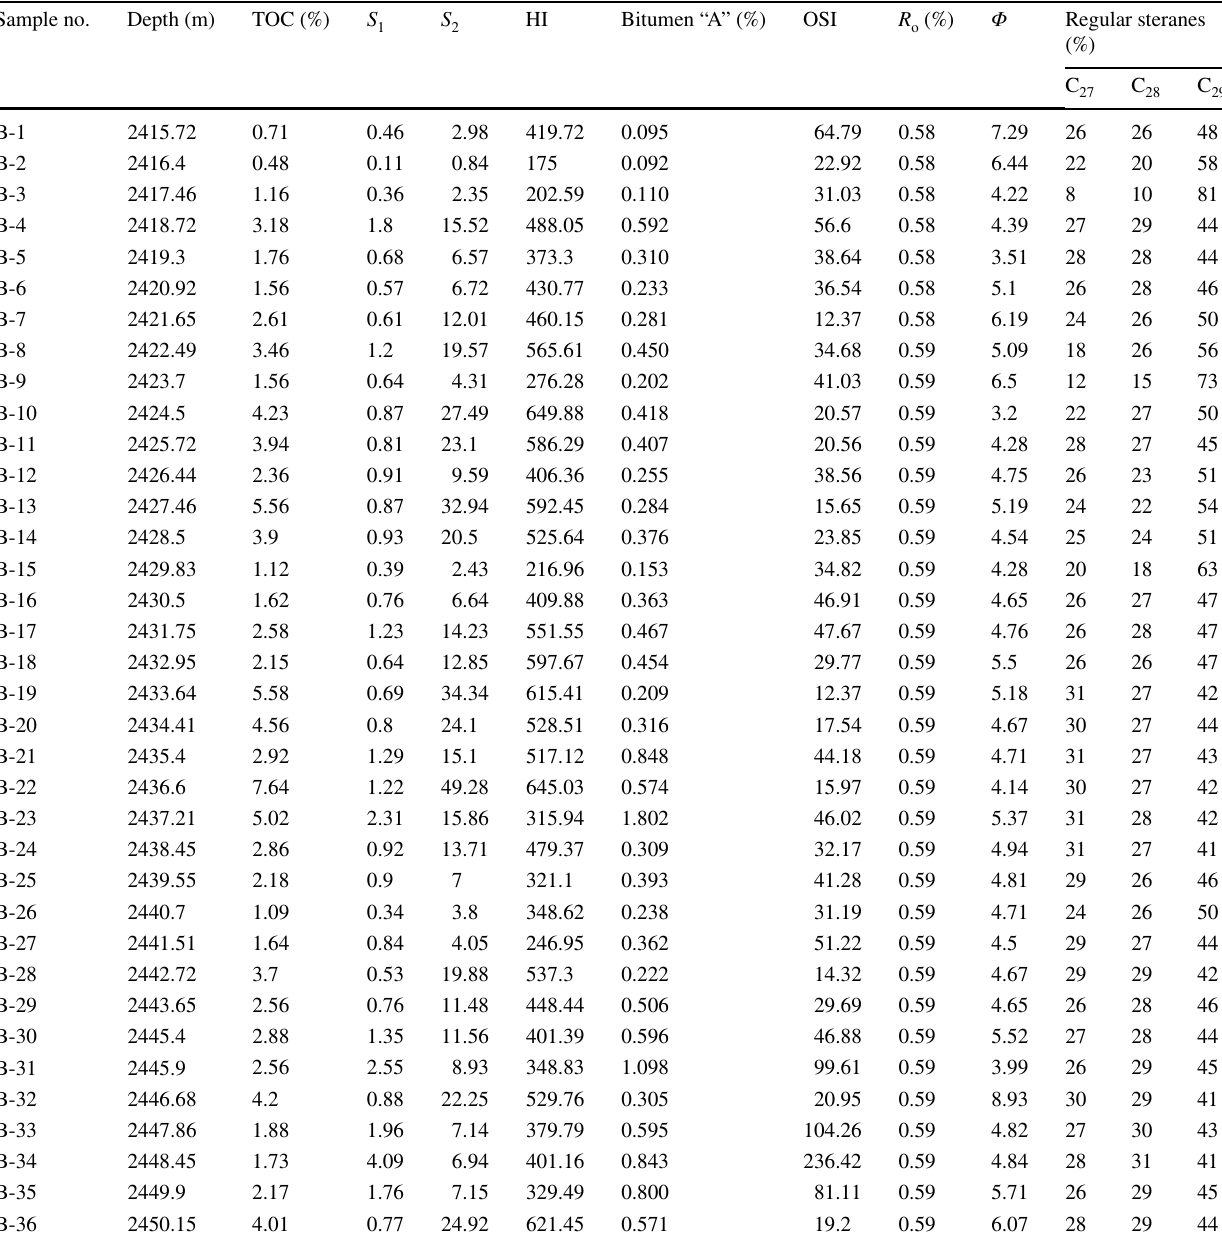
Table 1 Bulk geochemistry of the samples from well